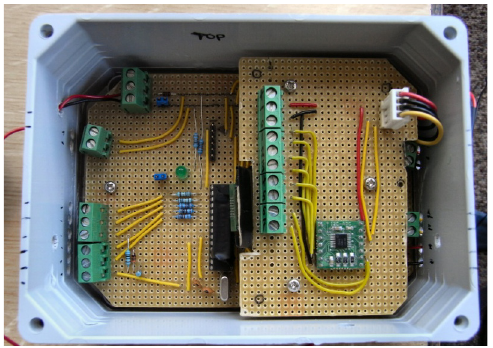
Figure 3. Prototype Smart Server [29].